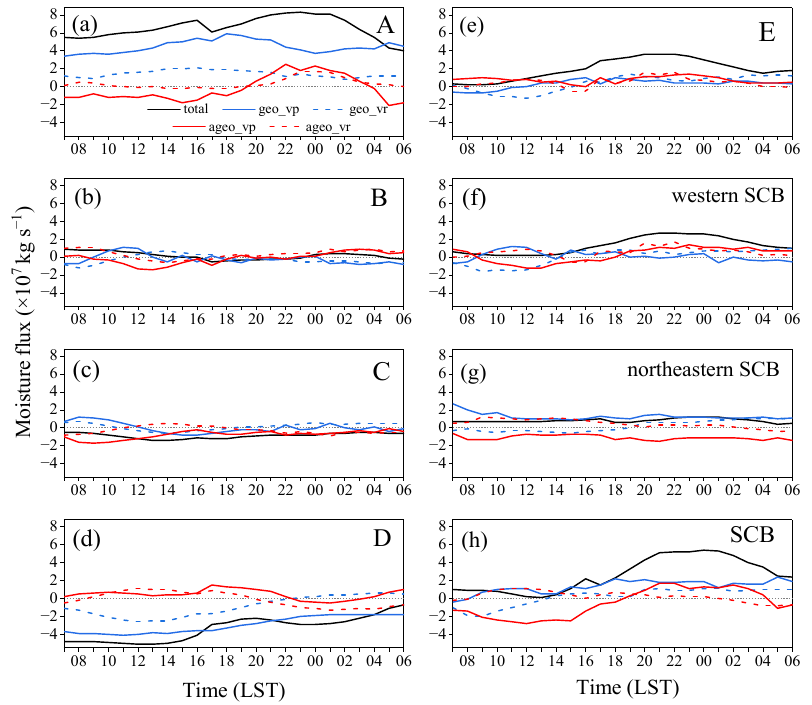
Figure 16. Diurnal variations of moisture budget at boundaries ( a ) A, ( b ) B, ( c ) C, ( d ) D, and ( e ) E and regions ( f ) western SCB, ( g ) northeastern SCB, and ( h ) SCB (the total, geo_vp, geo_vr, ageo_vp, ageo_vr in ( a ) represent the moisture budget caused by total winds, geostrophic creeping flows, geostrophic circumfluence flows, ageostrophic creeping flows, and ageostrophic circumfluence flows, respectively).